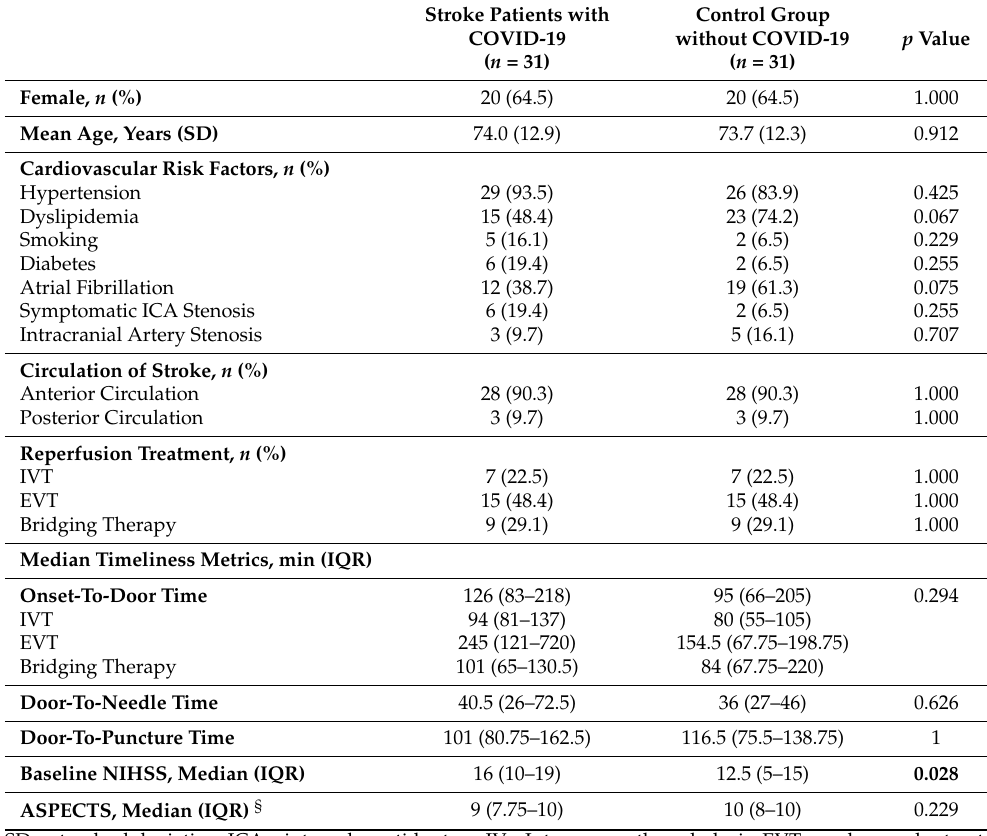
Table 1. Patient demographic data and stroke characteristics.